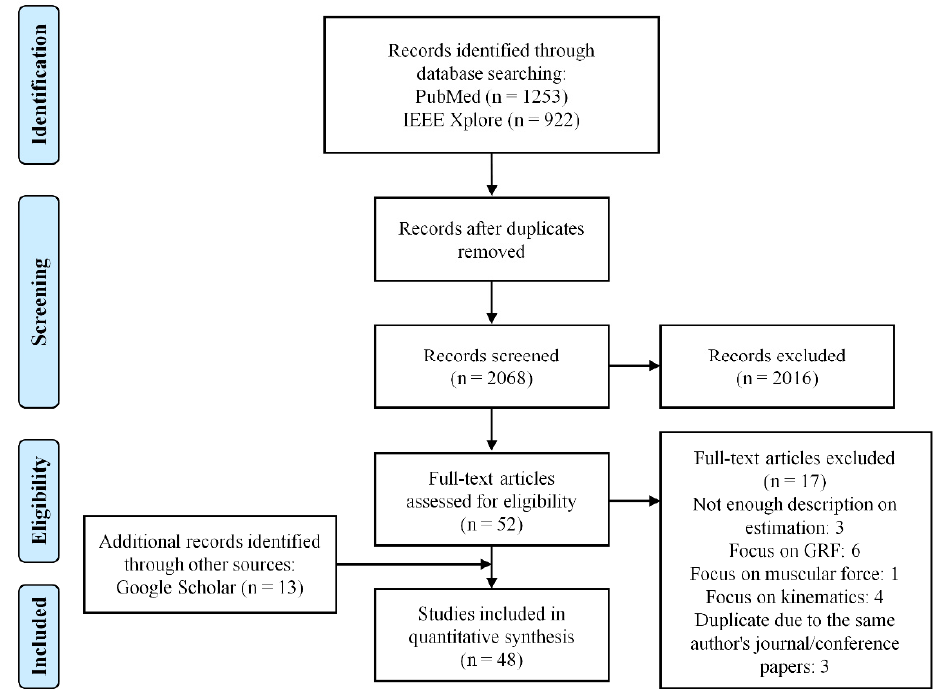
Figure 1. PRISMA flow diagram.